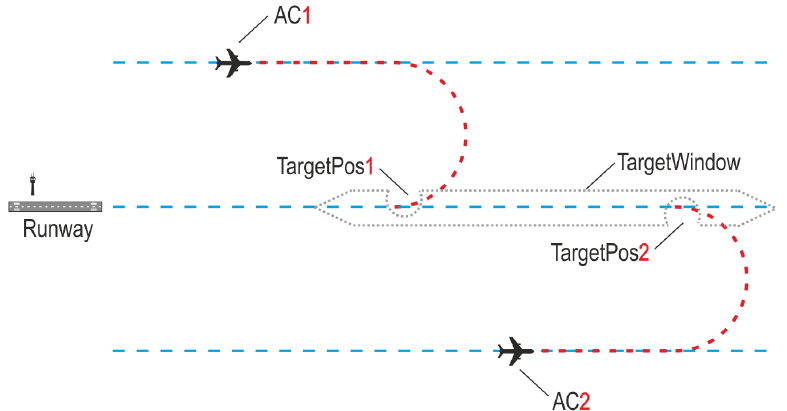
Figure 5. Schematic illustration of the TargetWindow concept displayed on an ATCO’s traffic situation display. The dashed pointed area (grey) moves with the time in the direction to the runways. The ATCO’s task is to turn the aircraft at the right time, as they fit in the open areas in the TargetWindow to meet their scheduled landing time perfectly. Additionally, ATCOs have the ability to quickly perceive if an aircraft is too fast or too slow. Thus, they can assess if these deviations will have any impact on the wake-vortex safety